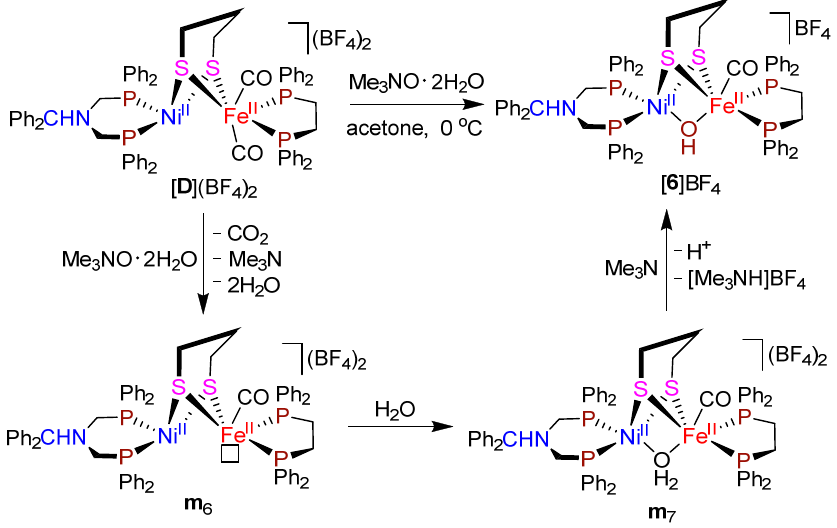
Scheme 6. Synthesis of dicarbonyl complex [ D ](BF 4 ) 2 and µ -hydroxo complex [ 6 ]BF 4 . While dicarbonyl complex [ D ](BF 4 ) 2 is an air-stable orange-red solid, µ -hydroxo complex [ 6 ]BF 4 is an air-stable orange-red solid. The IR spectra of [ D ](BF 4 ) 2 and [ 6 ]BF